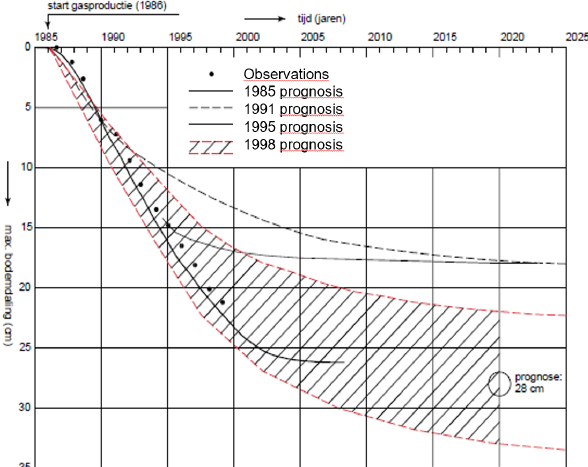
Figure 3. Prognosis for the deepest point on the Wadden Isle of Ameland over time. The current (2019) prognosis for the eventual subsidence is some 40cm. During the first decades of production, subsidence prognoses were strongly adjusted after each observation survey (© NAM; source: NAM, 1998; Eysink, 1995).